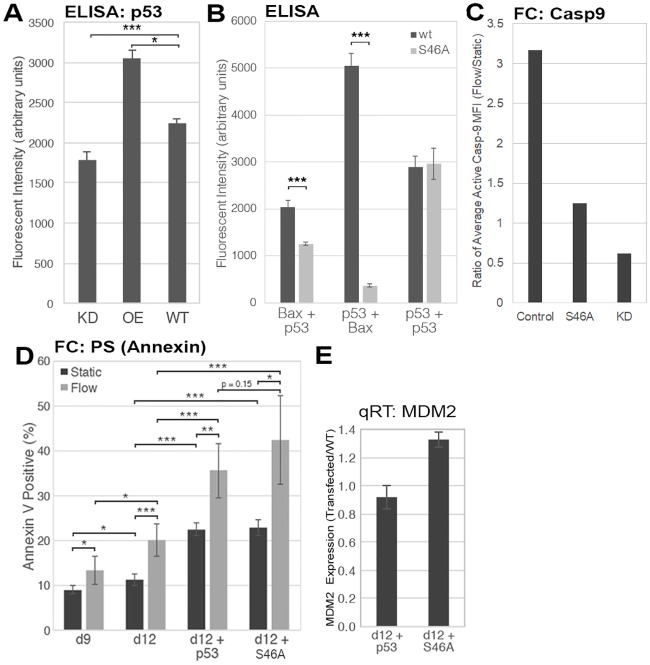
Shear-induced Caspase 9 activation in Mks is TIPA-dependent while Shear-induced PS externalization is p53-dependent, TIPA-independent.A, ELISA measuring total p53 levels in p53-KD, p53-overexpression, and wild-type Mks and normalized to basal lysate fluorescence. Unpaired t-test, n = 3 (technical replicates), *p < 0.05, ***p < 0.001, error bars: SD. B, ELISA measuring the amount of p53 bound to Bax (left), Bax bound to p53 (center), and total p53 in the sample (right) in wild-type CHRF cells (black) and CHRF cells expression p53-S46A (gray) following shear flow exposure at d4 post-PMA treatment. Fluorescence values were normalized to basal lysate fluorescence. Unpaired t-test, n = 3 (technical replicates), ***p < 0.001, error bars: SD. C, Percent of wild-type, p53-overexpression, p53-S46A-expressing, or p53-KD Mks at d12 with detectable expression of active Caspase 9 before (black) or after (gray) shear-flow exposure as measured by flow cytometry. Unpaired t-test, n = 3 (biological replicates), *p < 0.05, **p < 0.01, error bars: SD. D, Percent of cells expressing PS on their plasma membrane (Annexin+) in wild-type d9 and d12 Mks, Mks with wild-type p53 overexpression, and Mks expressing mutant p53-S46A before (black) or after (gray) shear-flow exposure. Unpaired t-test, n = 3 (biological replicates), *p < 0.05, **p < 0.01, ***p < 0.001, error bars: SD. E, Expression levels of MDM2 following overexpression of wt-p53 or expression of mutant p53-S46A quantified by qRT-PCR.